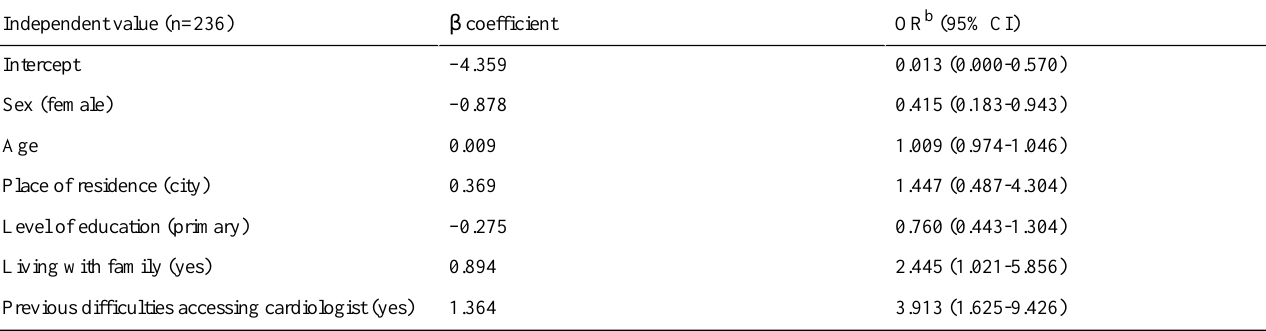
Table 4. Multivariate analysis between declared lack of telemedicine solution acceptance and particular independent values a .